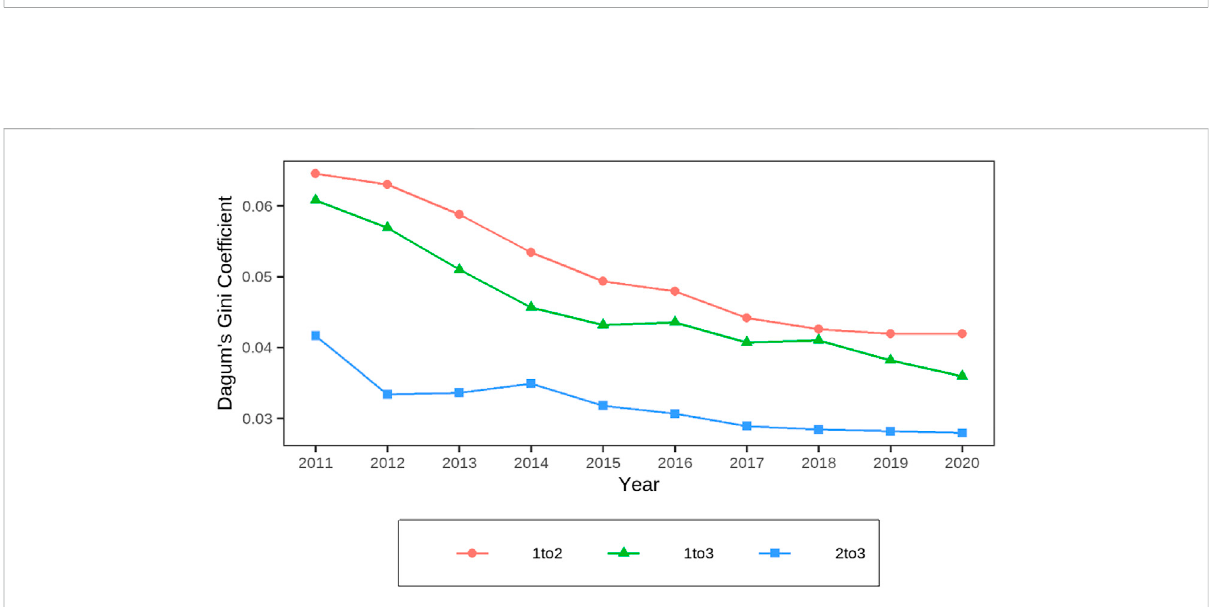
FIGURE 5 Inter-regional disparity in the level of high-quality economic development of the three major urban agglomerations in the Yangtze River Economic